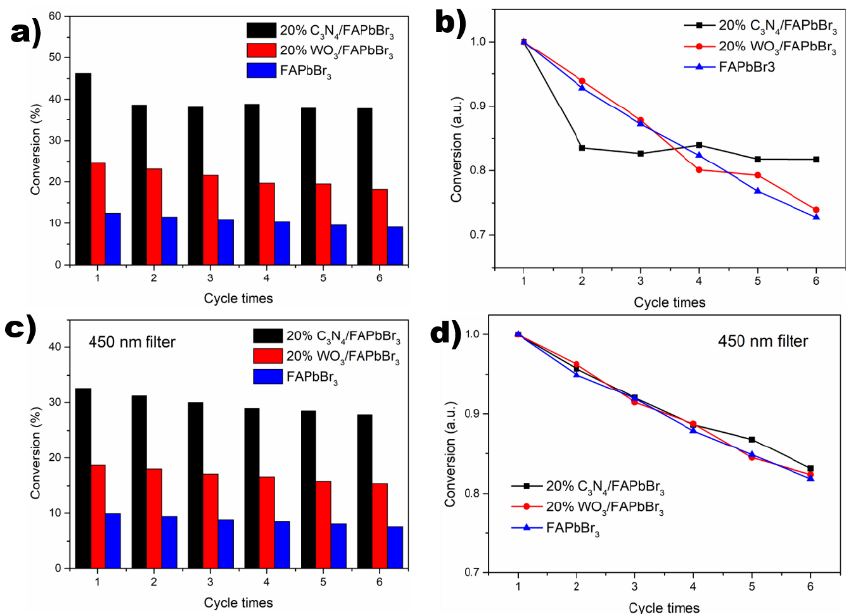
Figure 7. ( a ) The conversion rate of 20% FAPbBr 3 /C 3 N 4 and control groups under Xe lamp illumi- nation for 6 cycles; ( b ) the conversion rate relative to the first cycle under Xe lamp illumination; ( c , d ) conversion rate for six cycles and conversion rate relative to the first cycle when applying a 450 nm long-pass filter, respectively. Reaction conditions: photocatalyst (10 mg) and 0.1 mmol reactant, trifluorotoluene (1.5 mL) saturated with oxygen before experiments, irradiated by AM 1.5 G ( ca . 100 mW cm −2 ) for 4 h each cycle, under room temperature.